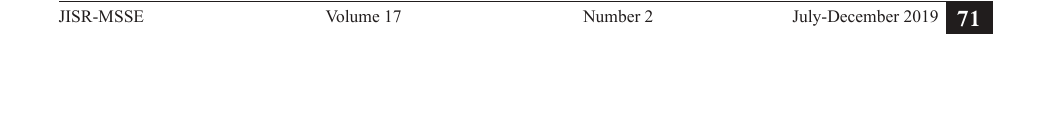
Figure1. Principal Leadership skills performance assessment